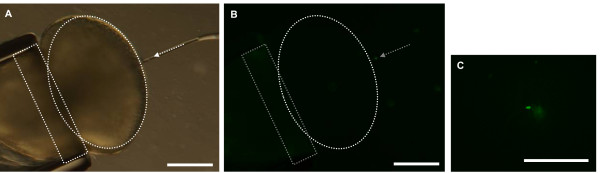
Rupture of fin cell plasma membrane upon injection. A: bright field view showing an intact cell at the tip of the capillary (grey arrow). B: Same view as A under fluorescent light, see the green dot of calcein entrapped into the cell cytoplasm. C: fluorescent view few seconds after cell injection. Four cells were injected in order to get a better representation of the different cases. Two cells were still intact: see the two bright spots of calcein still entrapped into cell cytoplasm, whereas the 2 others had a ruptured membrane: calcein was released and its green fluorescence diffused in the surroundings. Scale bar = 500 μm.